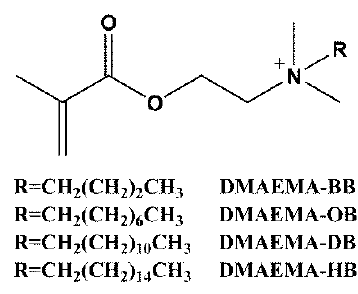
Figure 1. Structure of quaternary ammonium salts.